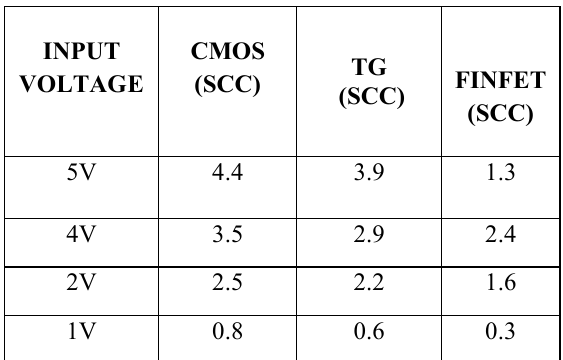
Table 3. Comparison between existing and proposed switched capacitor converter circuit with input and output voltages.